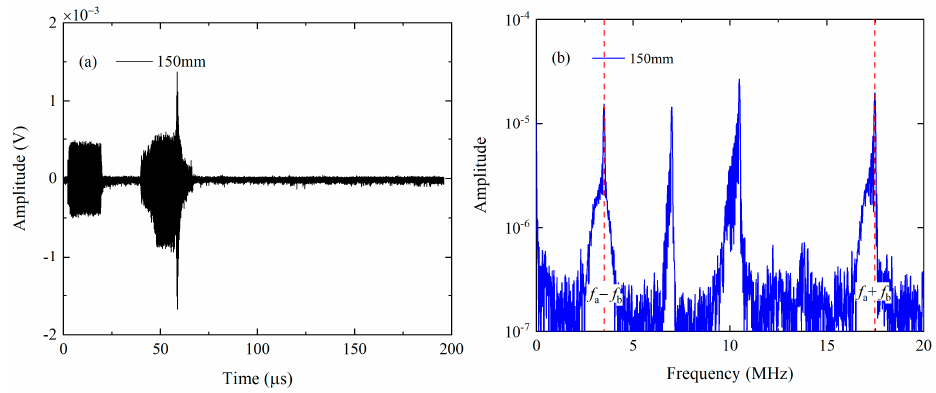
Figure 10. The processed time-domain signal ( a ) of the second mode triplet at 150 mm and its frequency spectra ( b ).